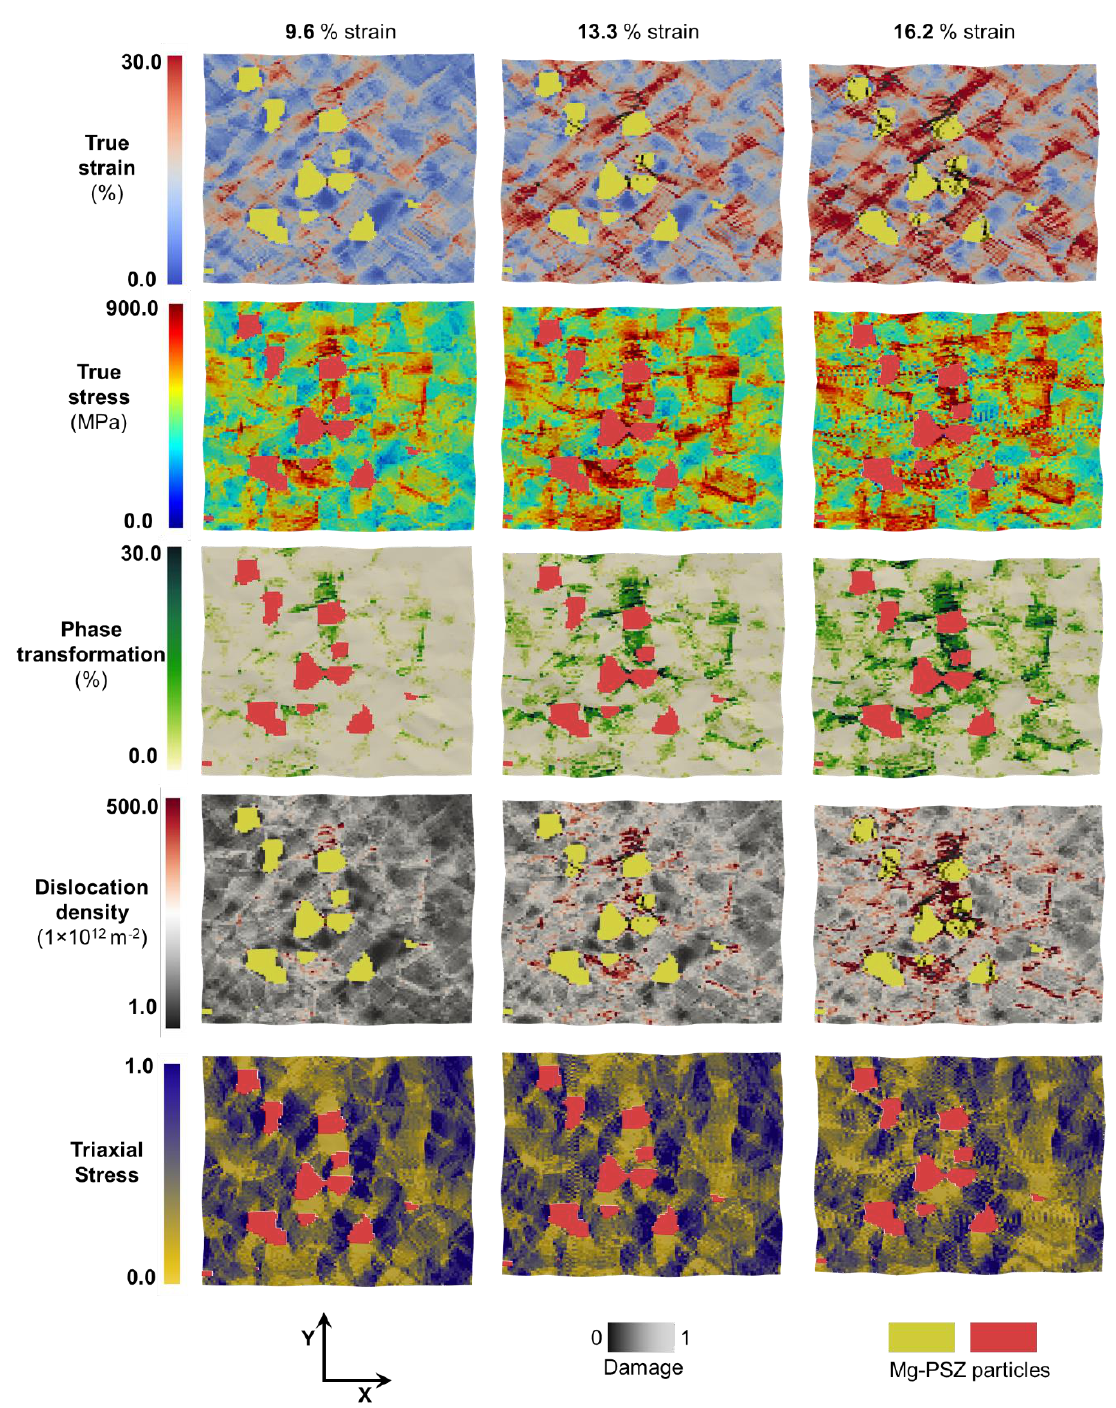
Figure 6. Comparison of locally distributed (from top to bottom) true strain, true stress, phase transformation, dislocation density, and triaxial stress in the austenitic matrix (from left to right) at 9.6%, 13.3%, and 16.2% global true strain.